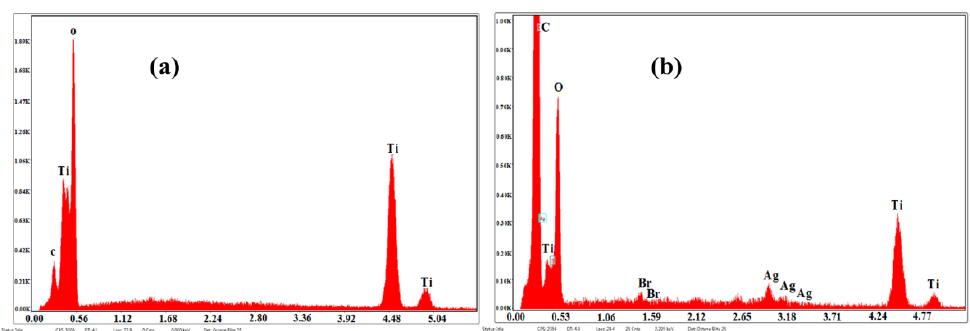
Figure 2. FE–SEM images of neat paper ( A , B ), paper–TiO 2 ( C , D ) and paper–TiO 2 –AgBr ( E , F ).